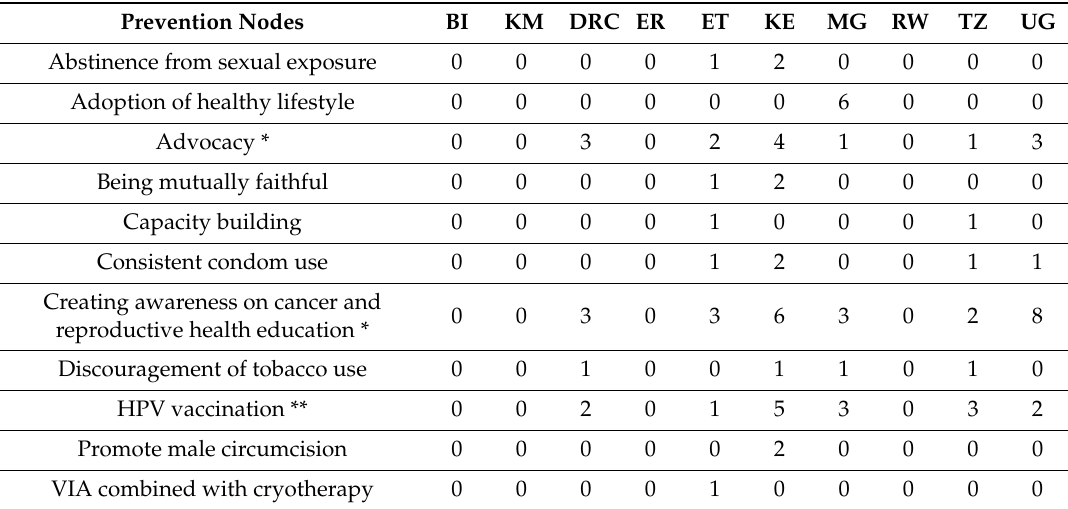
Table 4. Prevention nodes against the East African